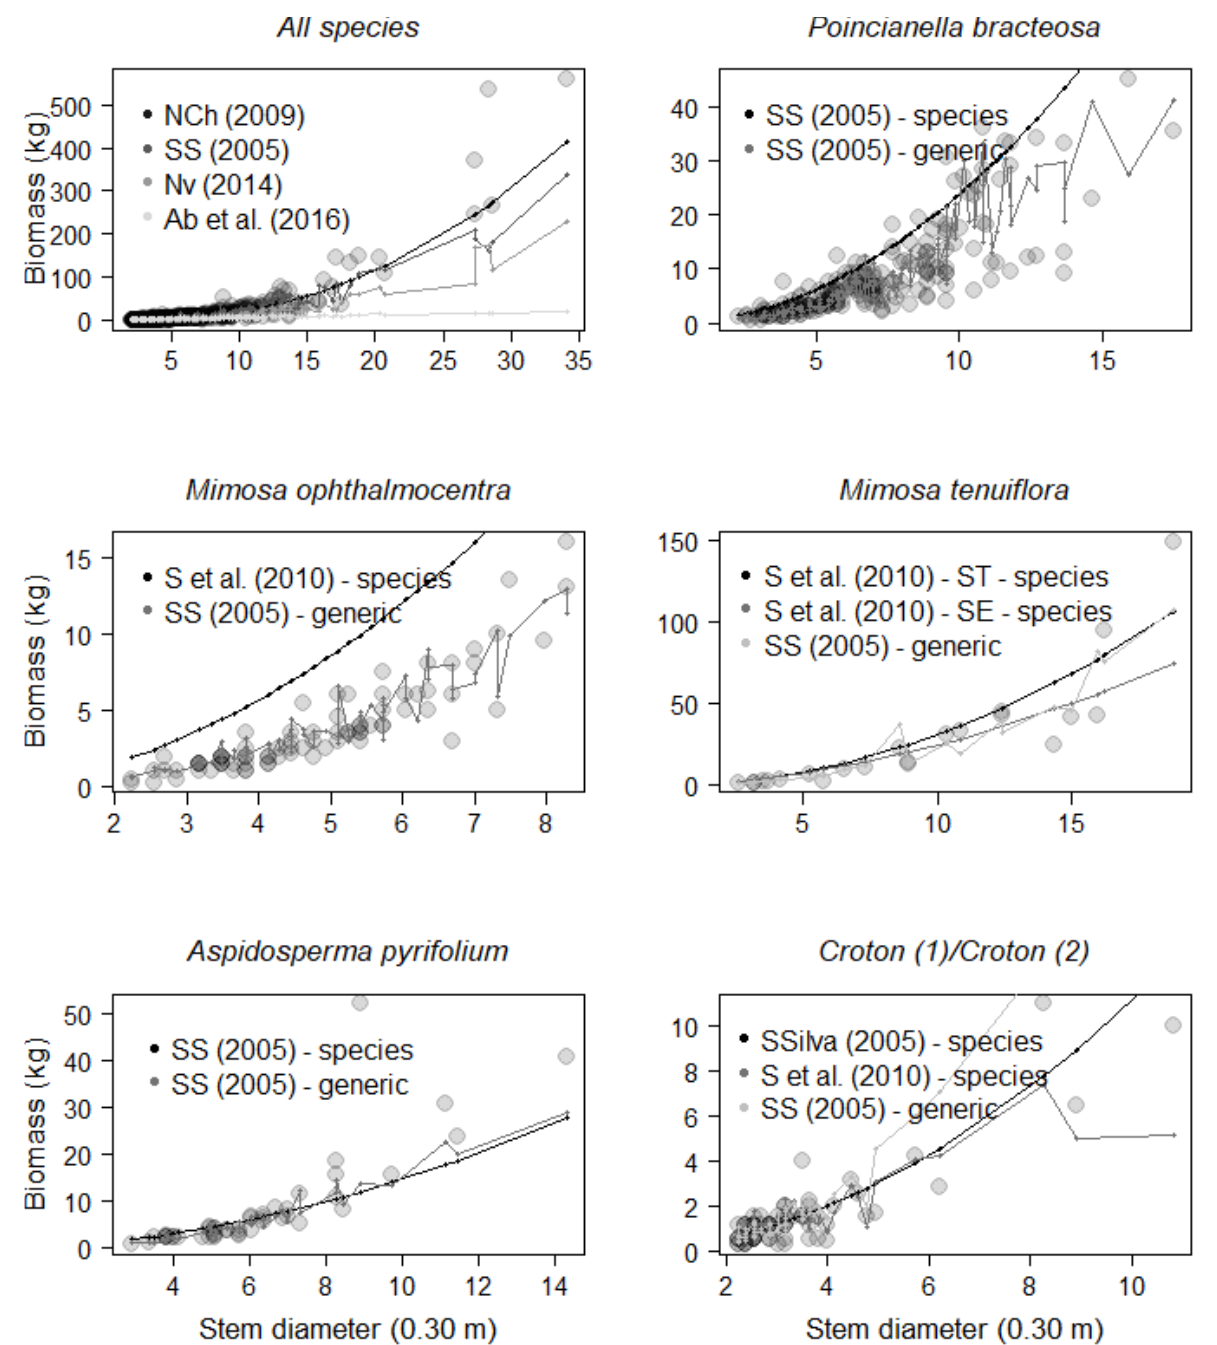
Figure 3 - Relation between biomass (kg) above the soil and the base diameter of the trees (Db cm). Each point corresponds to an individual weighted tree. The dashed lines correspond to the validation of the generic and local equations for the entire database, for the four species. Croton blanchetianus (1) and Croton rhamnifolius (2) correspond to the database for the Croton genus. Note . Abreviations: Nch (2009) -Equation of Návar-Chaidez (2009); SS (2005) - Generic equation and species of Sampaio and Silva (2005); Nv (2014) - Equation of Návar-Cháidez (2014); Ab et al. (2016) - Equation of Abreu et al. (2016); S et al (2010) - Equation of species of Sampaio et al. (2010): ST (Serra Talhada area); SE (Sertânea area); SSilva (2005) - Equation of species of Sampaio and Silva